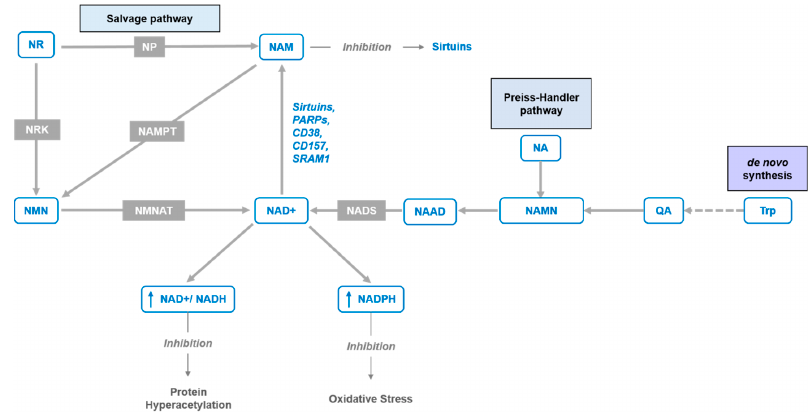
Figure 1. NAD + synthesis pathways. The figure depicts NAD + de novo pathway from tryptophan (Trp) through quinolinic acid (QA), Preiss–Handler pathway from nicotinic acid (NA) via nicotinic acid adenine dinucleotide (NAAD) and NAD synthetase (NADS), and “salvage pathways” from nicotinamide riboside (NR) and nicotinamide mononucleotide (NMN) via purine nucleoside phosphorylase (NP) and nicotinamide phosphoribosyltransferase (NAMPT) enzymes or nicotinamide ribose kinases (NRK) and NMN/NaMN adenylyltransferases (NMNAT), respectively.